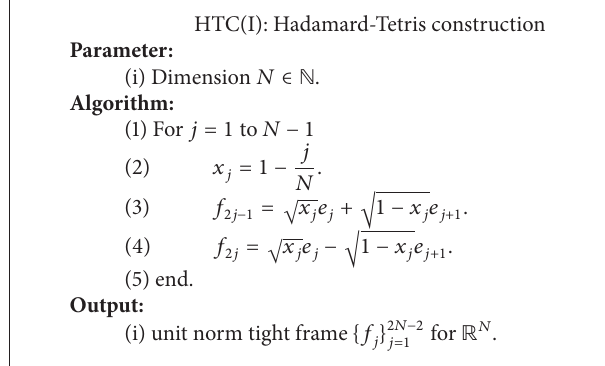
Algorithm 1: The HTC(I) algorithm for constructing a unit norm tight frame with (2𝑁 − 2) -elements for R 𝑁